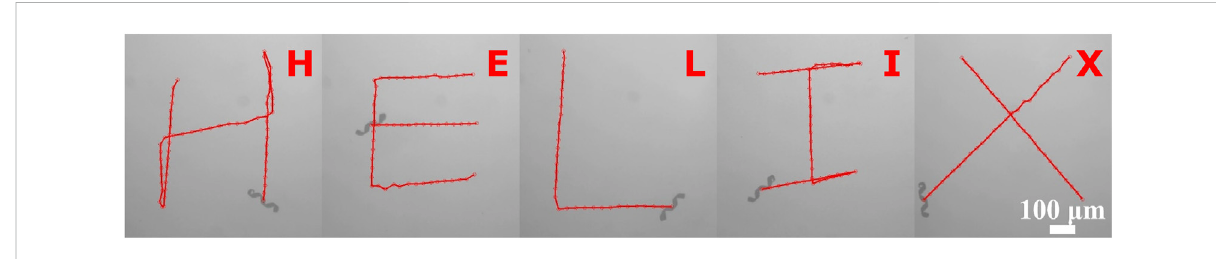
FIGURE 4 The trajectory of a helical microrobot following pre-programmed